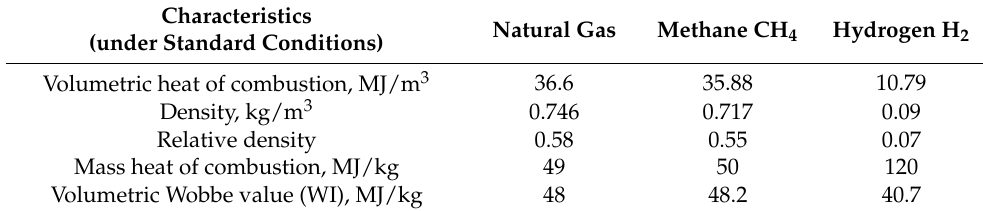
Table 1. Characteristics of natural gas, methane and hydrogen